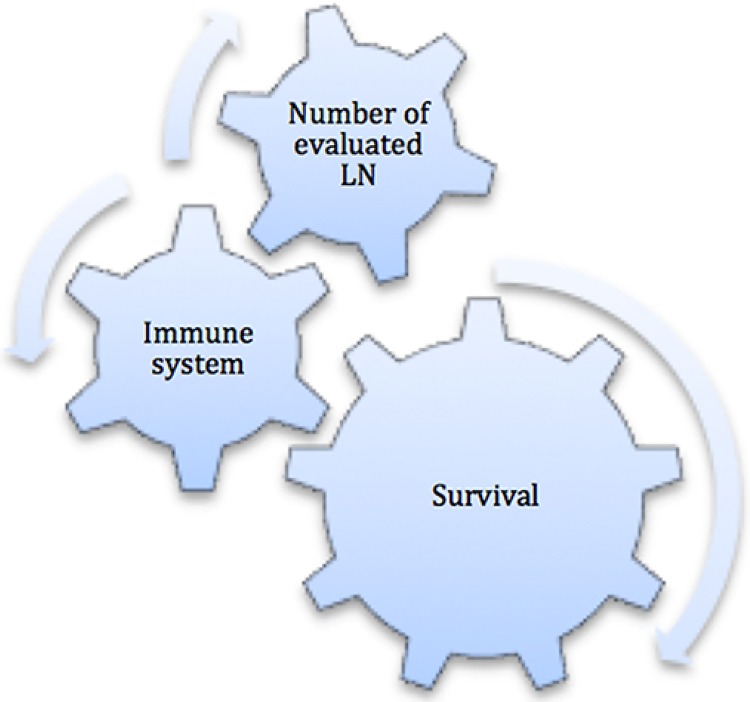
Immune system as confounder influencing both number of evaluated LN and survival.LN: lymph node.